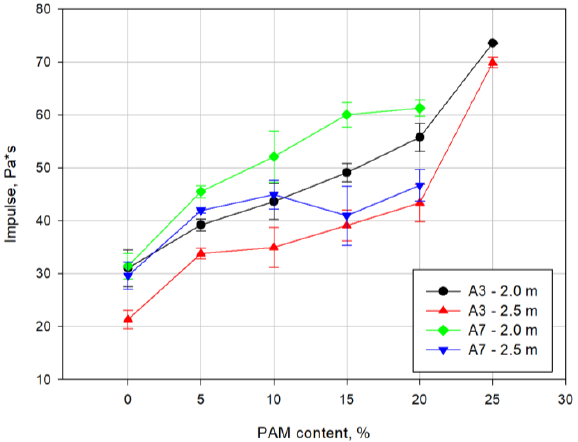
Figure 9. Curves of the specific impulse as a function of the PAM powder content.